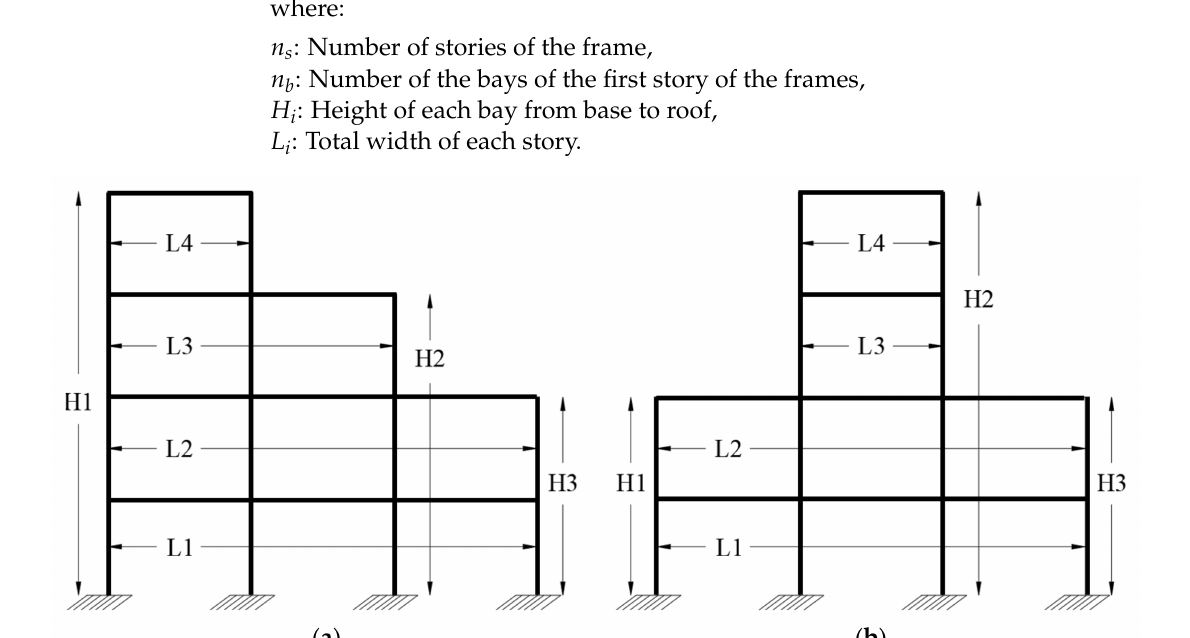
Figure 2. Frame geometry for irregularity indices definition for: ( a ) stepped type of setbacks; ( b ) towered type of